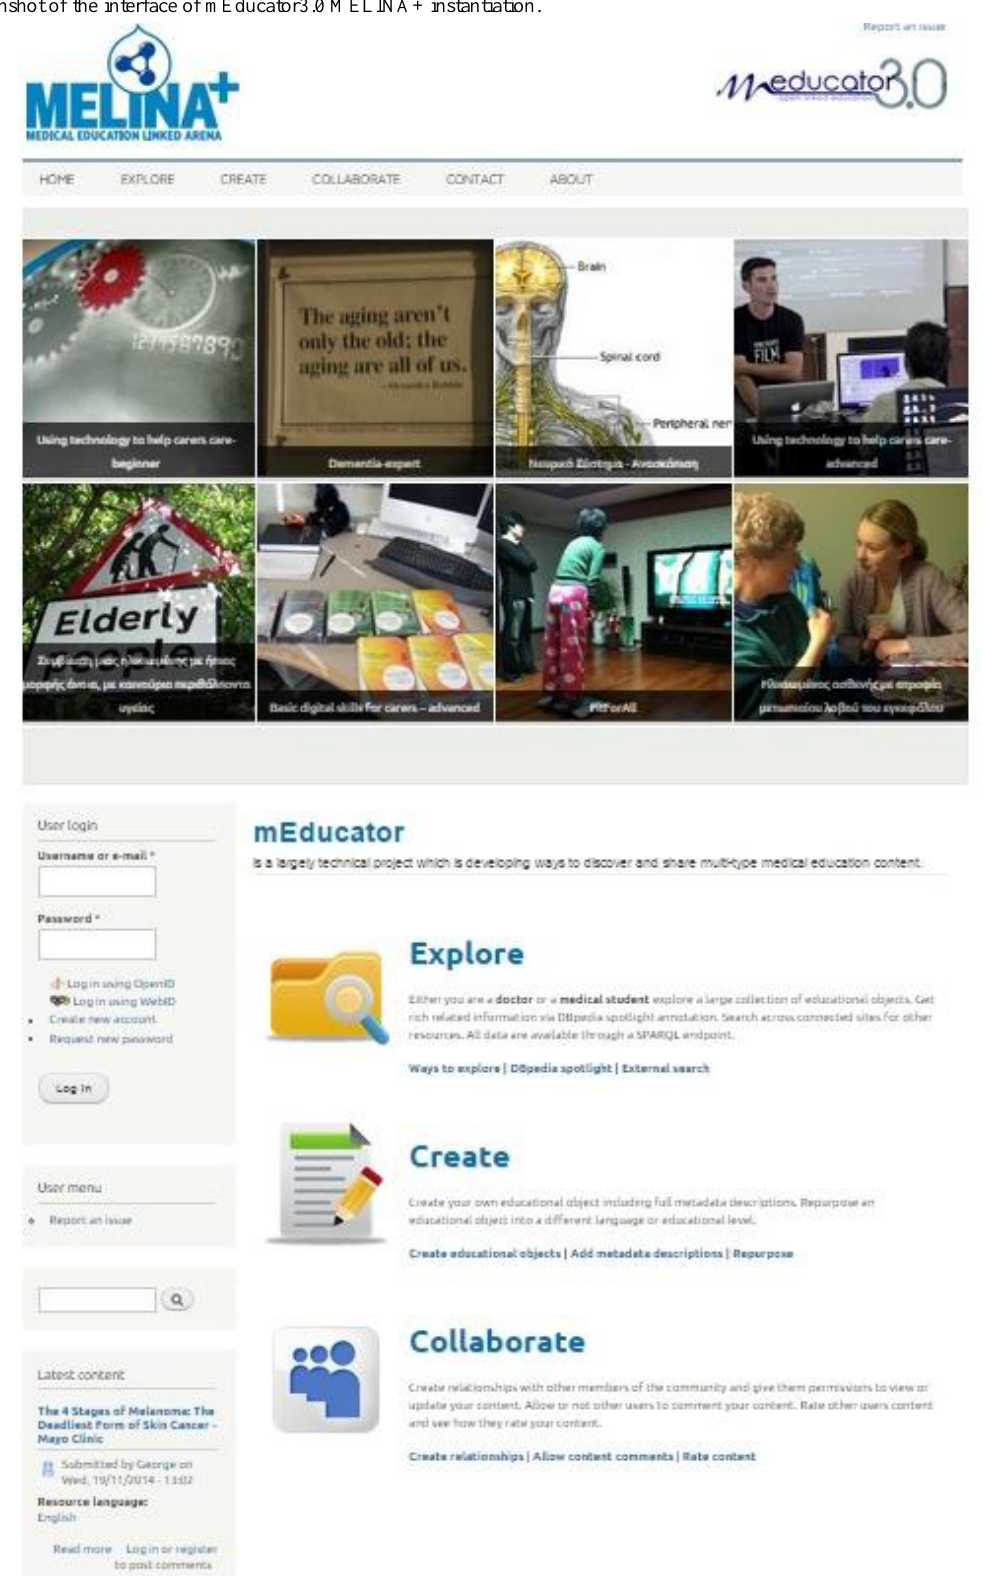
Figure 3. Screenshot of the interface of mEducator3.0 MELINA+